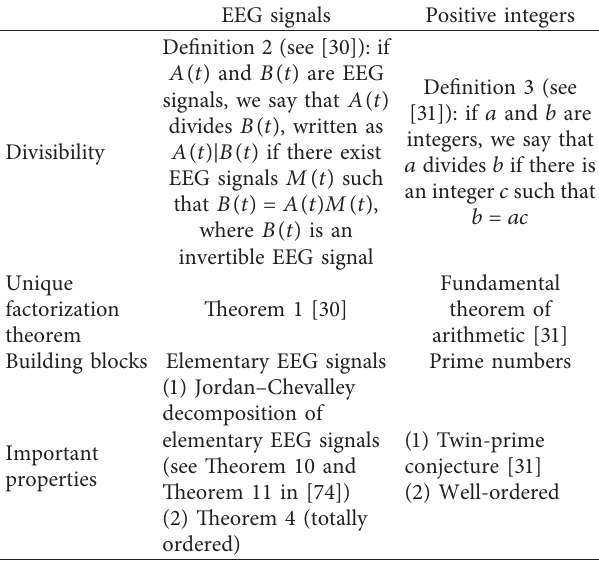
Figure 5: The analogy between the set of EEG-signal square matrices and the precede operator and the set of real numbers and the greater-than operator. Table 7: The similarity between elementary EEG signals with the prime